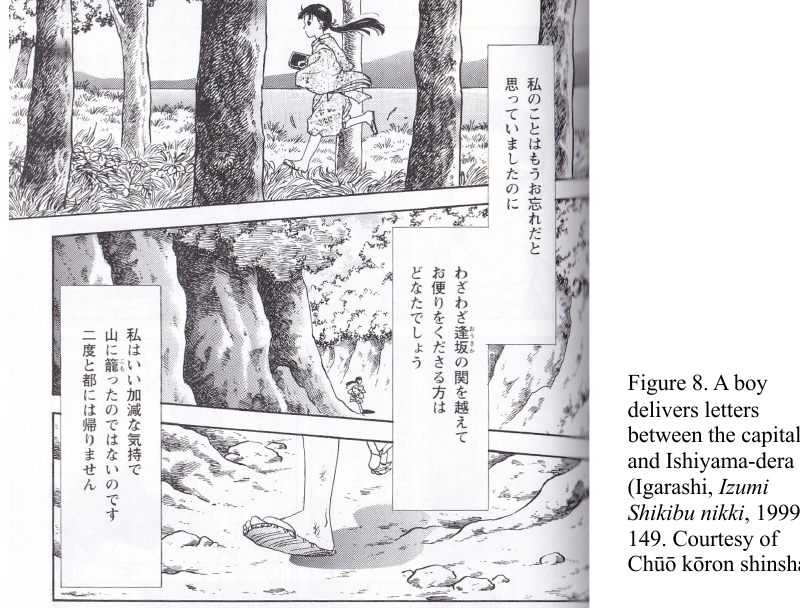
Figure 8. A boy delivers letters between the capital and